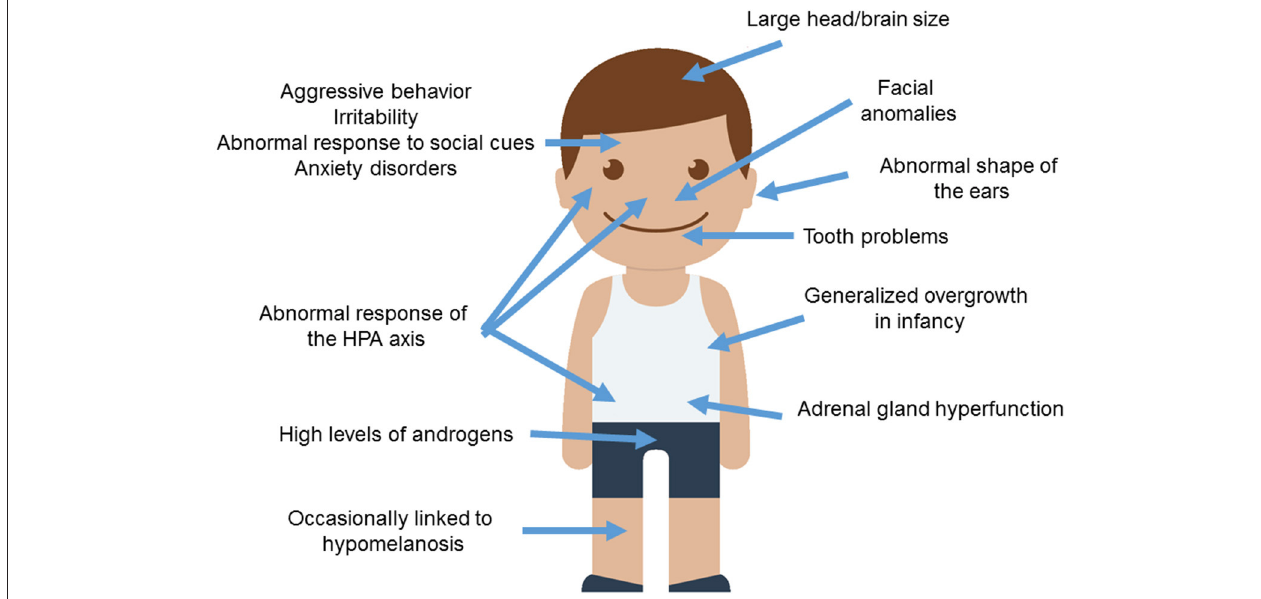
FIGURE 1 | Anomalous presentation of domesticated traits in people with ASD. Main clinical features observed in ASD patients and concerning the domestication syndrome are shown. The child diagram was gathered from Iconfinder output (available at http://www.iconfinder.com/icons/525448/